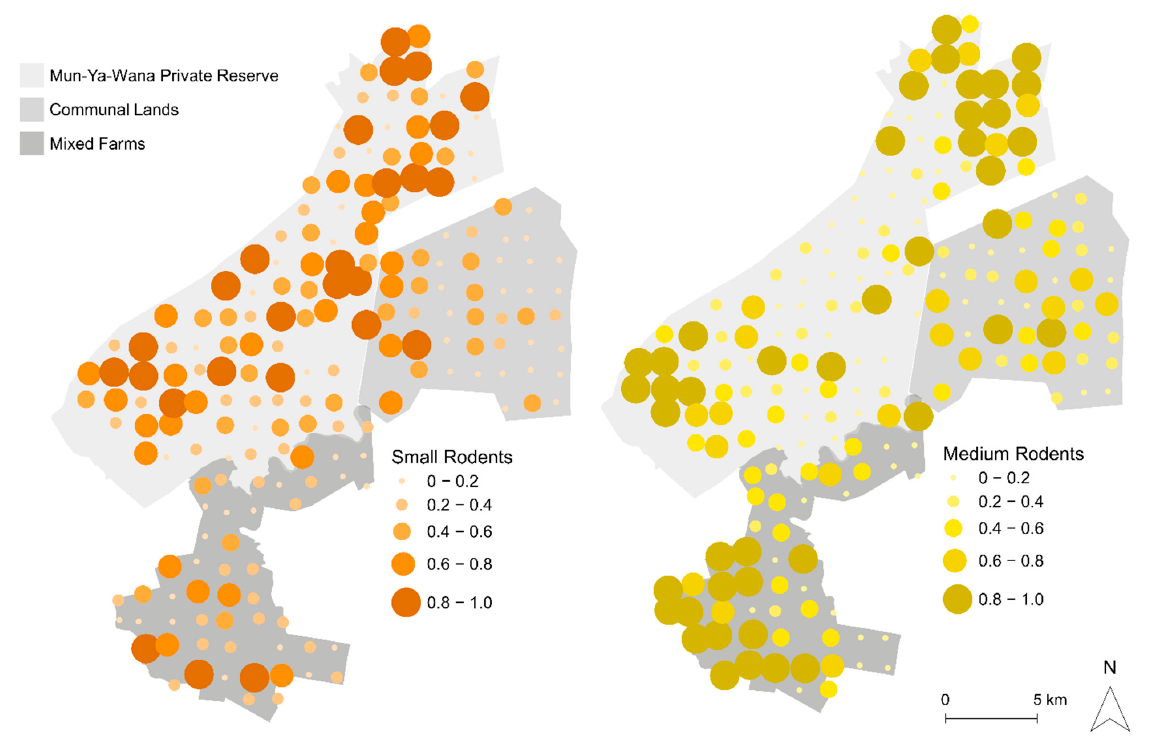
Figure 2. Map of the study area showing rodent distributions: small-size rodents are in orange and medium-size rodents in yellow. The size of each point is equivalent to abundance value, as indicated in the respective legend.